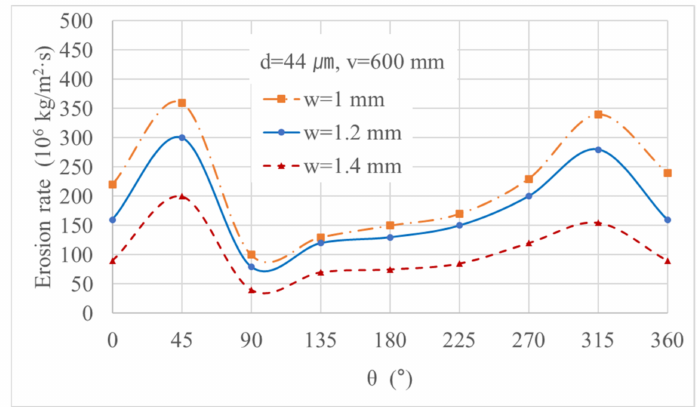
Figure 7. Erosion rate density based on the distance between the parts.